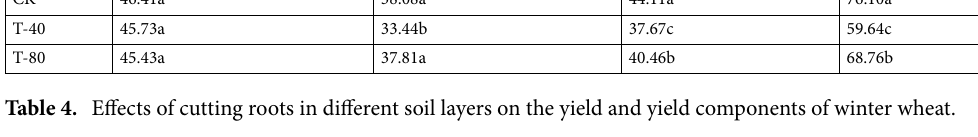
Table 4. Effects of cutting roots in different soil layers on the yield and yield components of winter wheat.